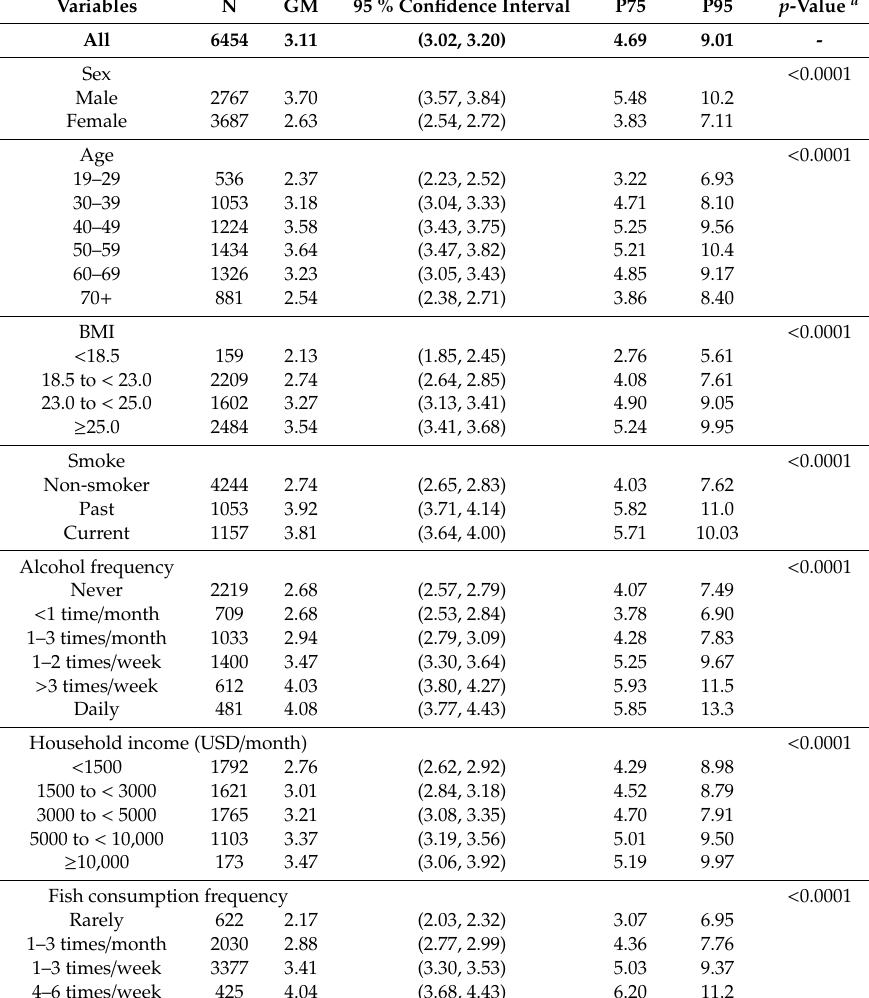
Table 1. Blood Hg distributions by demographic variables ( µ g /